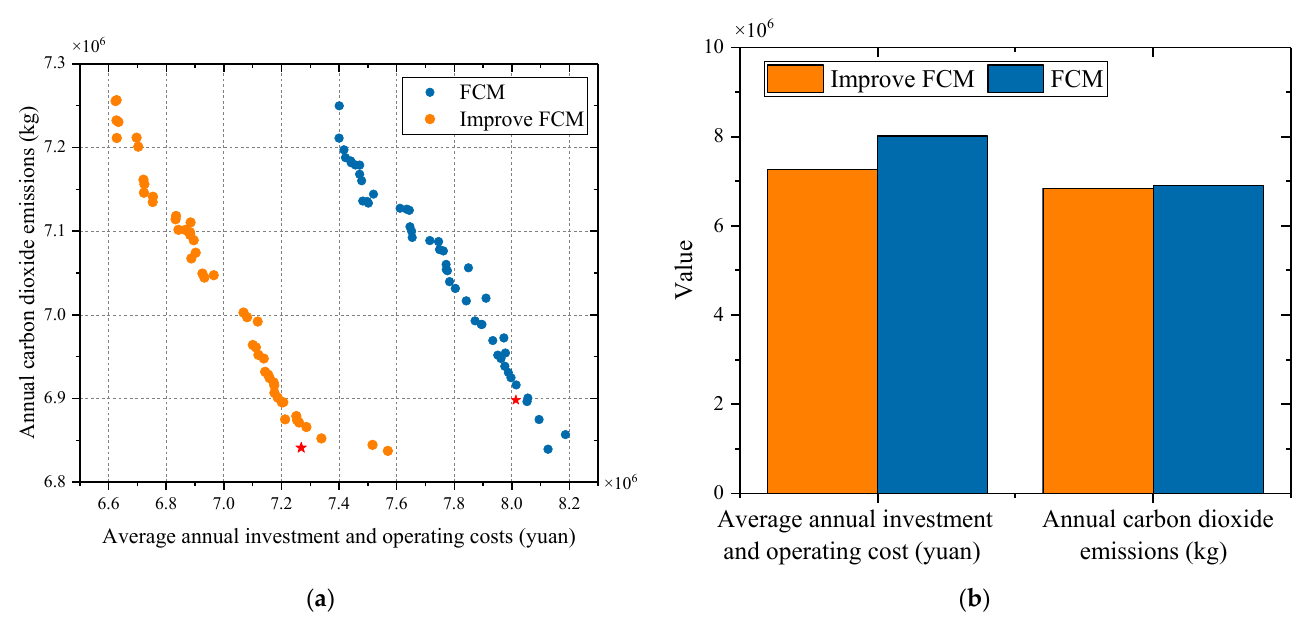
Figure 15. ( a ) The pareto solution set FCM clustering result; ( b ) best solution.